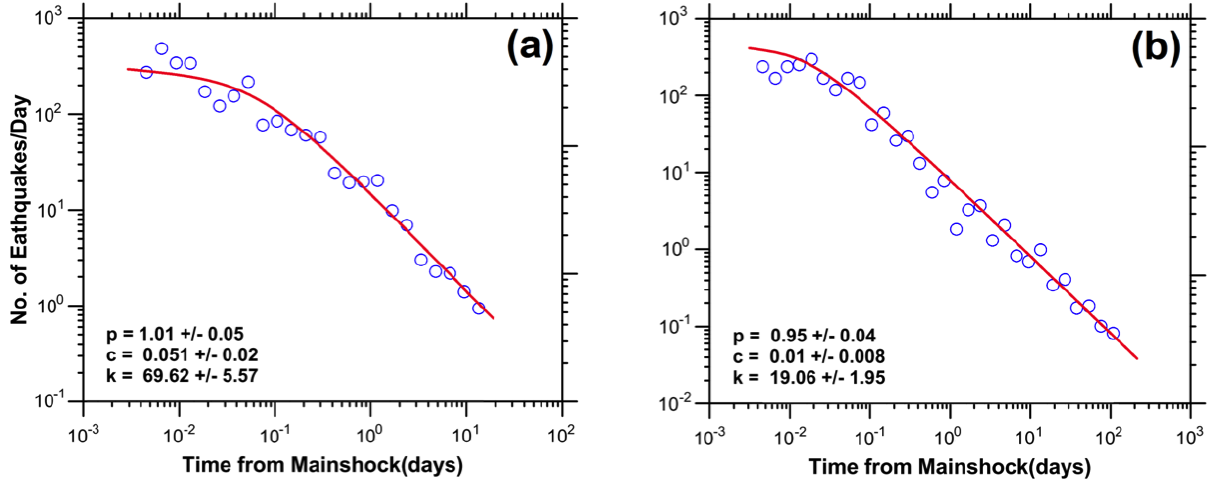
7.8) and (b) second W